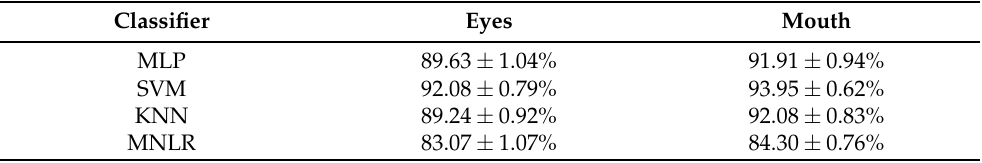
Table 15. Results on the palsy lesion assessment on the criteria of accuracy using regional